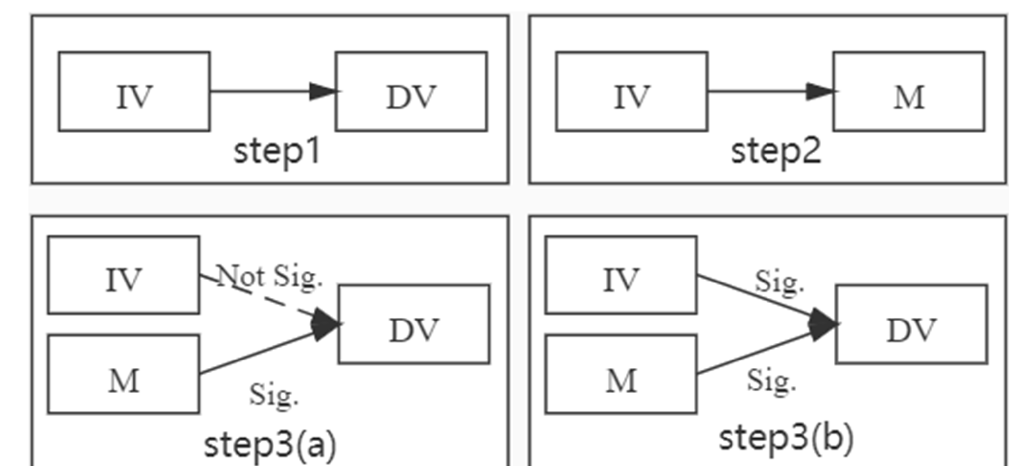
Figure 2. Mediation test steps. Note 1: IV: Independent variable; M: mediator; DV: dependent variable. A → B means regress A on B (i.e., A has influence to B). Note 2: Step 1, IV → DV is significant. Step 2: IV → M is significant. Step 3: